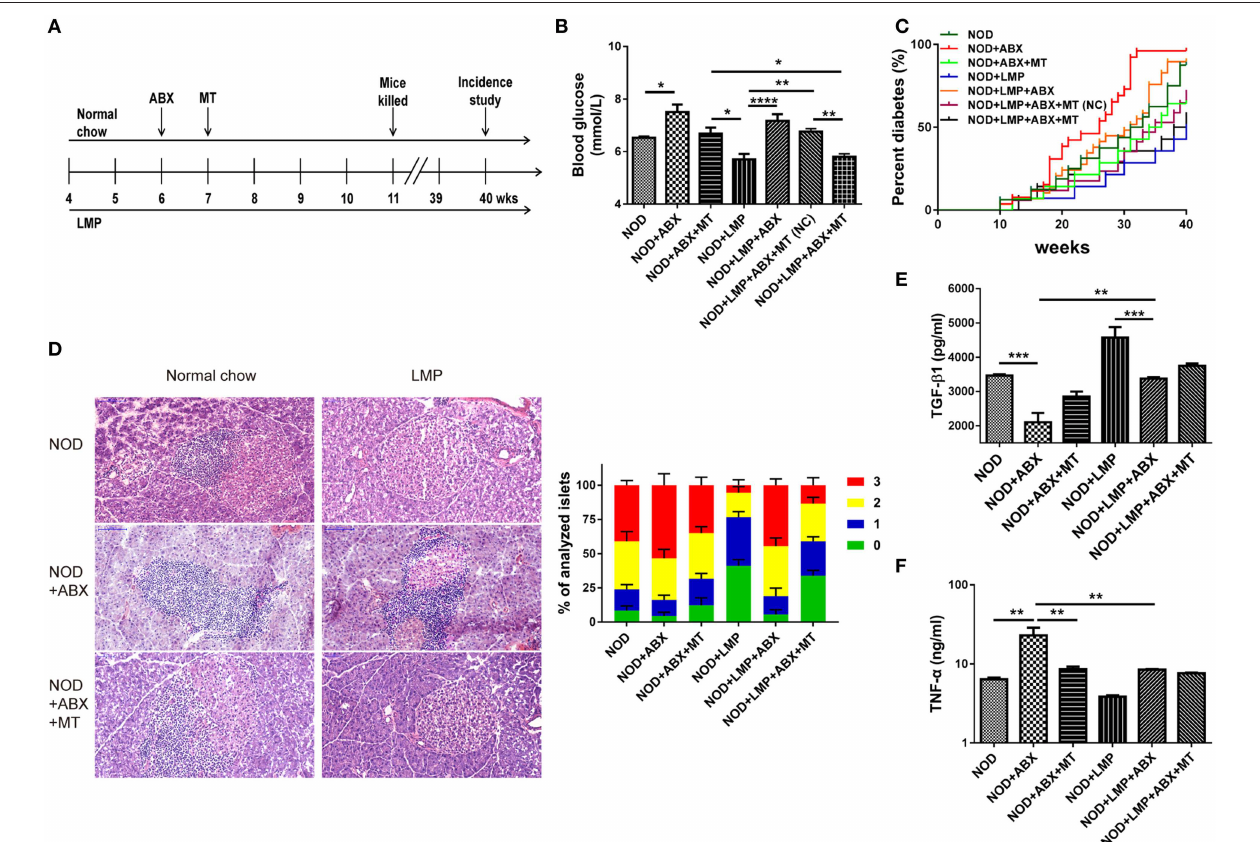
FIGURE 4 | Protective effects of LMP on T1D are abolished by antibiotics (ABX)-induced abberation of gut microbiota. (A) Animal experiment design for ABX treatment and microbiota transfer (MT). (B) After ABX and MT treatment, the blood glucose was measured at 11-weeks age. (C) After ABX and MT treatment, the diabetes incidence was shown from 4 to 40 weeks of age. n = 20. (D) H&E staining of pancreatic islets from NOD mice at the age of 11-weeks age. Insulitis score was quantified. Scale bar, 100 µ m. (E) The anti-inflammatory cytokine TGF- β 1 was quantified in pancreas by ELISA. (F) The pro-inflammatory cytokine TNF- α was quantified in pancreas by ELISA. Bars represent means ± SEM; * p < 0.05; ** p < 0.01; *** p < 0.001, and **** p < 0.0001.